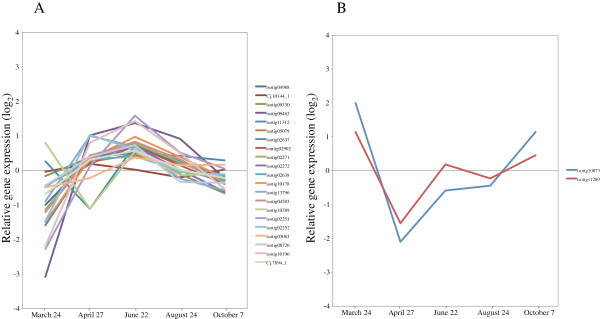
Expression of phenylpropanoid metabolism-related genes in cambial region during xylem formation. A) Upregulated genes involved in lignin biosynthesis. B)PAL4 (isotig 10873) and 4CL3 (isotig 11289). The individual targets are summarized in Additional file 3. All expression data are presented on a log2 scale.